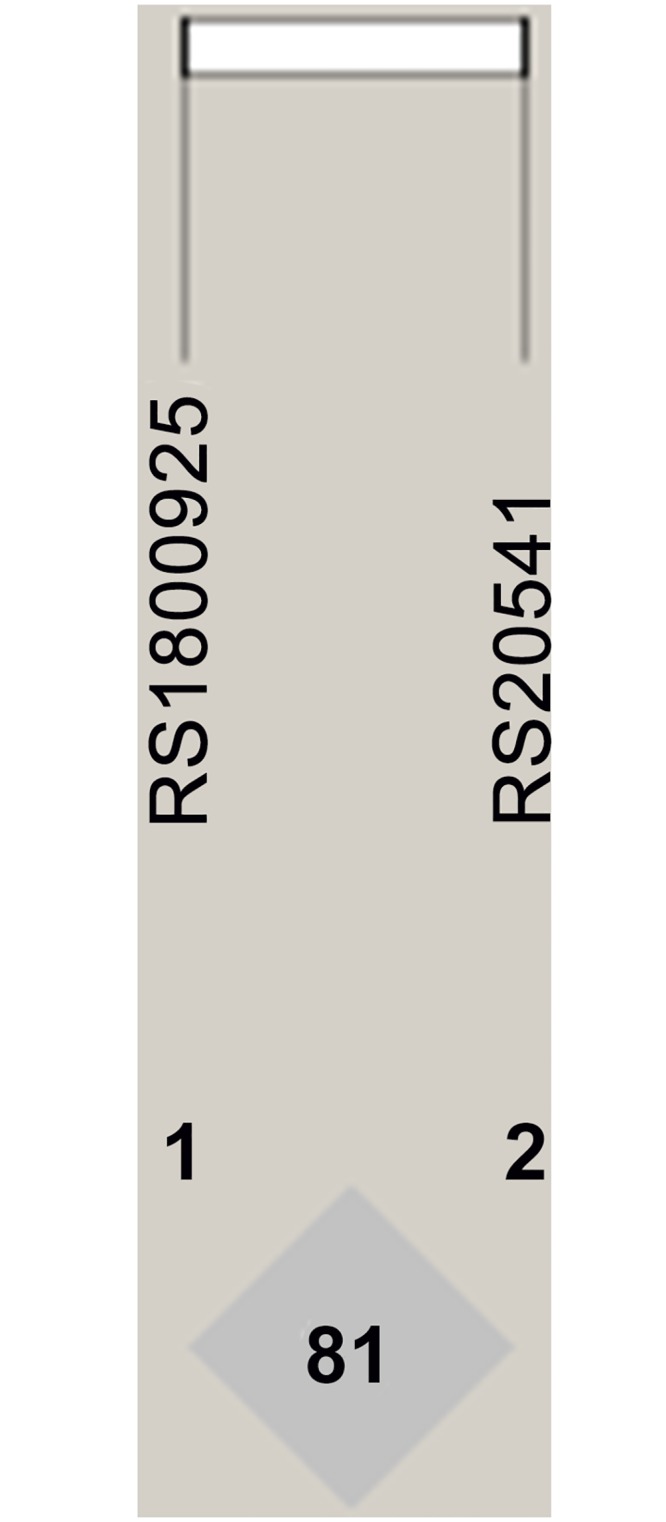
Pairwise linkage disequilibrium (LD) of 2SNPS in IL13 gene.